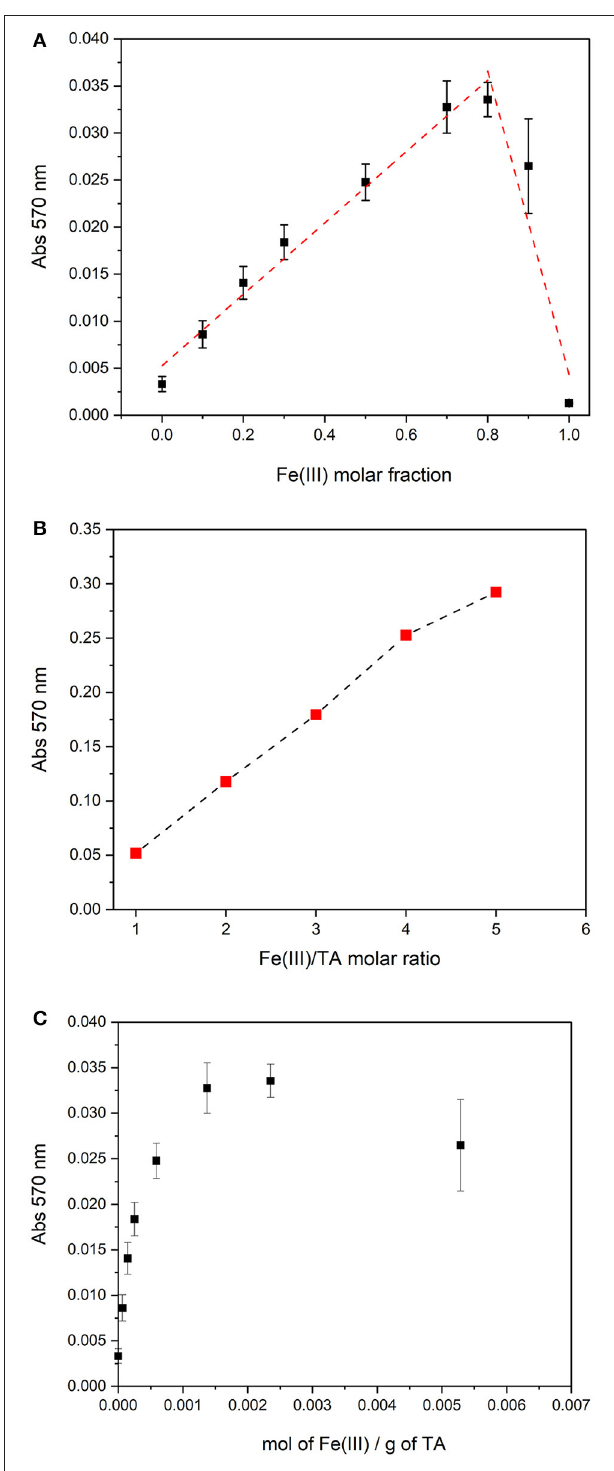
FIGURE 3 | (A) Job’s plot for solutions with a total concentration of 2.00 × 10 − 5 mol L − 1 and pH = 4.0. (B) Absorbance at 570nm of Fe(III)/TA solutions at pH ∼ 4 with different molar ratios (TA concentration 2.00 × 10 − 5 mol L − 1 ). (C) Absorbance at 570nm of Fe(III)/TA solutions at pH = 4.0 as a function of the total mol of Fe(III) per total mass of